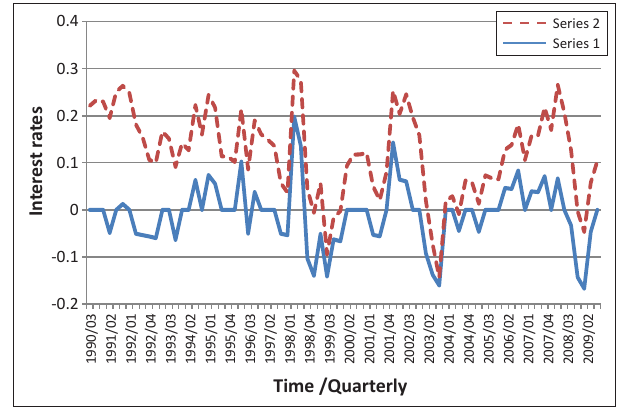
FIGURE 1: Actual interest rates (Series 1) and interest rates proposed by Taylor (Series